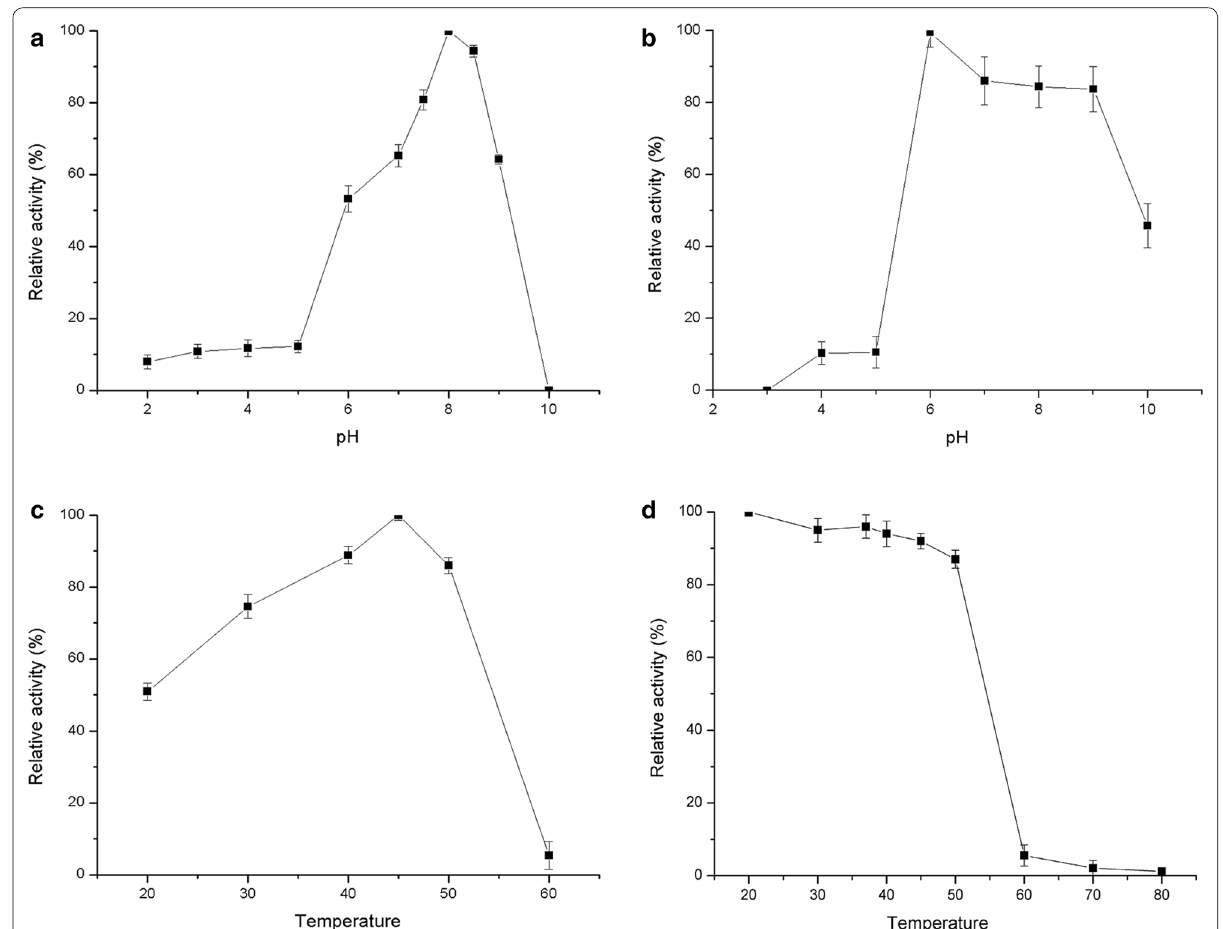
Fig. 2 Effect of temperature and pH on the enzyme activity of recombinant ZENC. a Effect of pH on the enzyme activity. b pH stability of recombinant enzyme. c Effect of temperature on the enzyme activity. d Thermostability of recombinant enzyme. Error bars represent the standard devision of values and every case was carried out three experiments